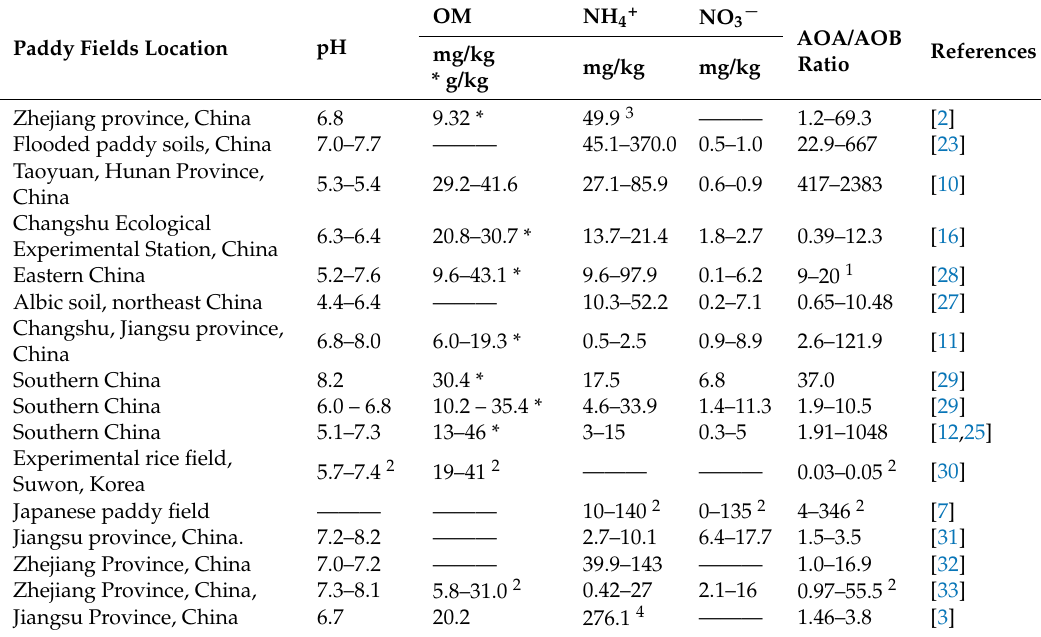
Table 1. Edaphic properties of selected paddy